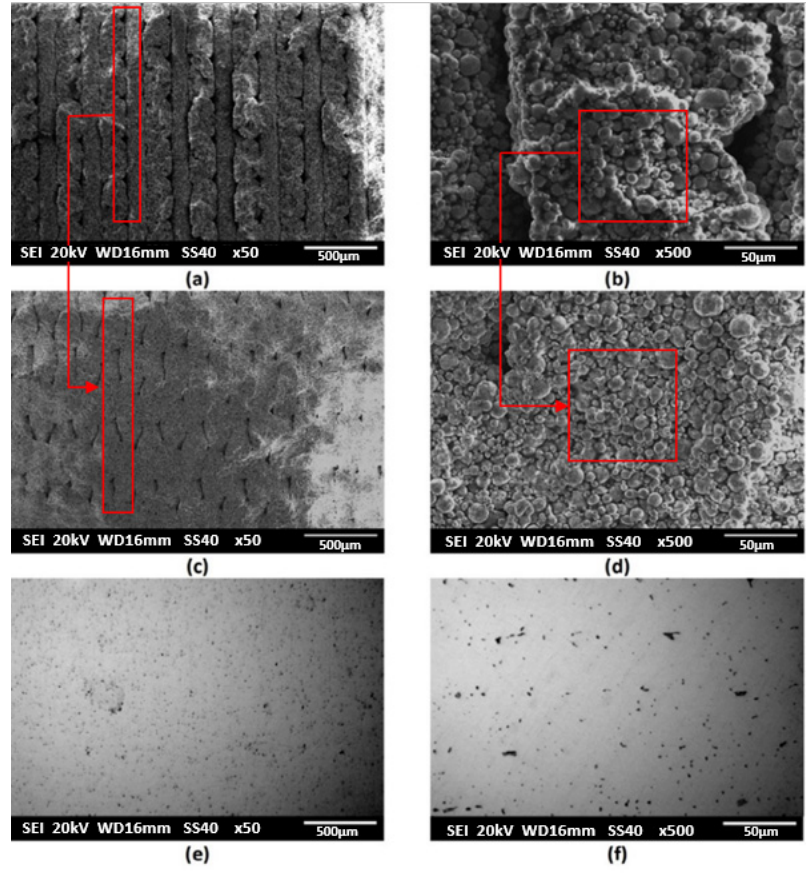
Figure 6. SEM images of ( a , b ) green part, ( c , d ) brown part and ( e , f ) sintered final part. ( a , c , e ) ×50, ( b , d , f ) ×500. ( a – c ) Detail of the porosity inherent of the layer-to-layer manufacturing process. ( b – d ) Detail of the porosity inherent of the filament due to the distance between metal particles. After printing, the samples were immersed in solvent to remove the partially soluble wax component. Completion of the solvent debinding stage for the green parts required 10 h. A weight loss of 2.8% has been registered, and the samples had enough strength to be handled. The copper parts after the solvent debinding stage, brown pieces, are shown in Figure 6c,d. The main difference between green and brown stages is that the wax part of the binder system has been removed. Consequently, the agglomeration between the metal powder particles looks less significant and the polymeric film that covered them also becomes less thick. In addition, the limits between the different deposited layers that form the part geometry are less well defined, although pores and holes are still detected. In Figure 6d, it can be seen that adjacent copper particles are still bonded by part of the binder system, probably by the HMW (backbone) polymer, ensuring that these have an enough strength to be handled. Interconnected capillary voids are observed, which can allow the flow of backbone polymer and gaseous decomposition products of degradation of the remained binder. The micrographs of the polished transversal section of a copper part obtained after the complete thermal cycle, which includes the thermal debinding of the HMW binder and the possible remaining soluble wax residue, and the final sintering stage for material consolidation and densification, are shown in Figure 6e,f. No remains of the binder system are observed, so the chemical and thermal debinding are effective and have not negatively interfered in the sintering of the material. The sintering process